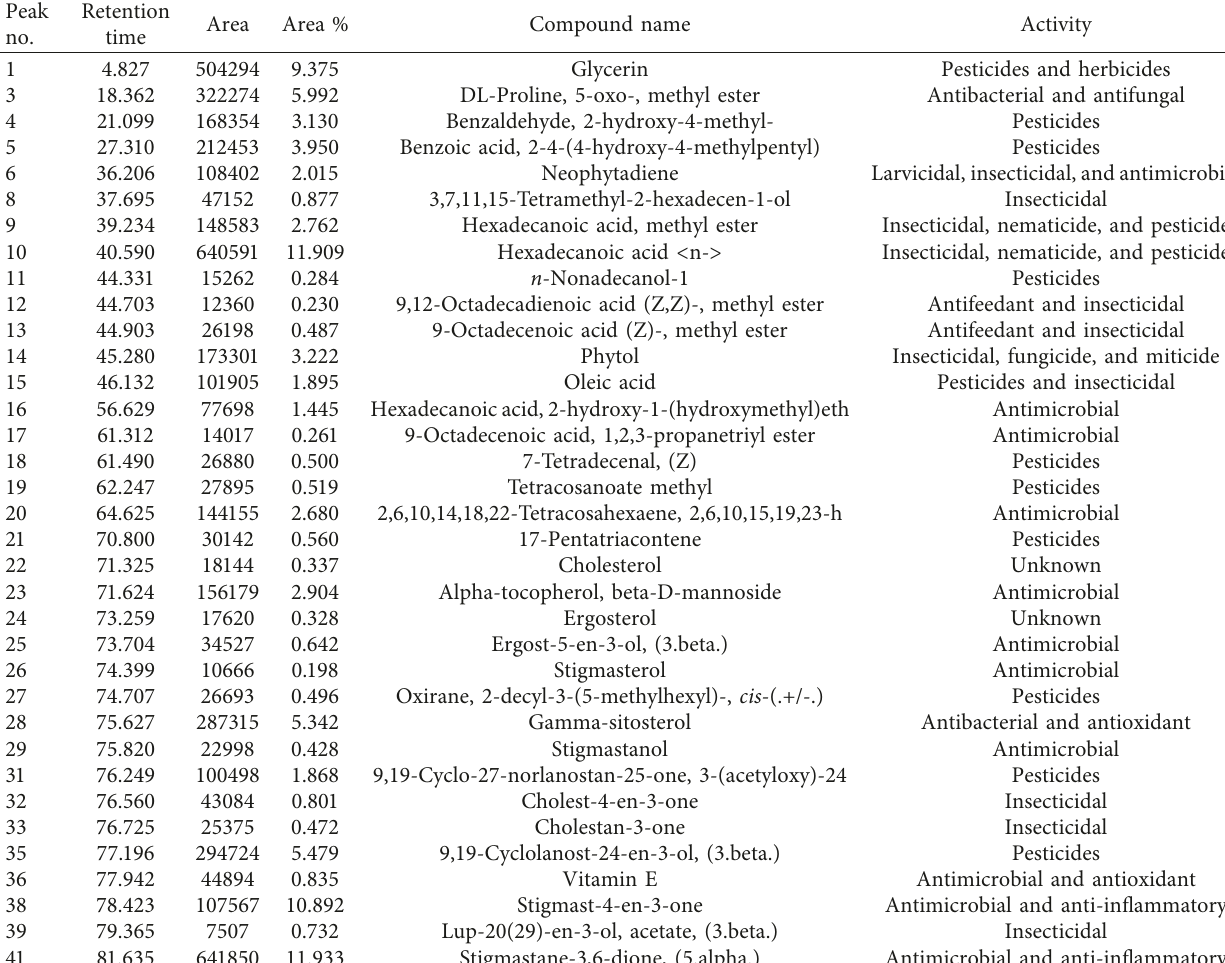
Figure 4: Chromatogram of GC-MS analysis of methanol extract of Azolla pinnata . Table 3: Chemical compositions in methanol extract of Azolla pinnata